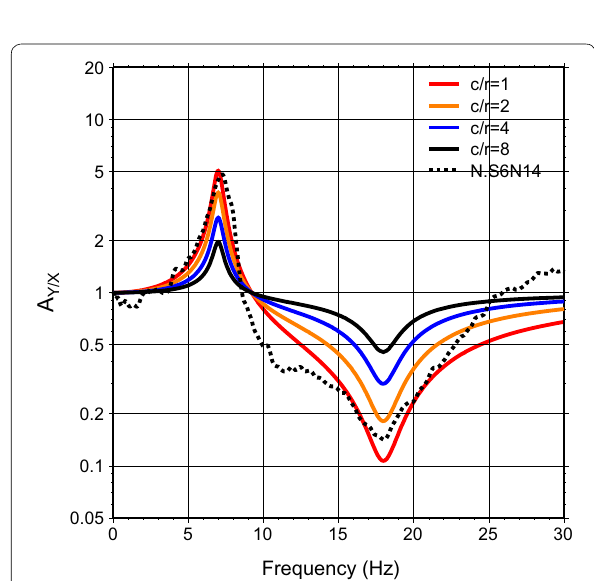
Fig. 12 Theoretical Y/X amplitude spectral ratios calculated using a natural vibration model. Natural frequencies of the X and Y components were set to 18 and 7 Hz, respectively, and the damping constant was set to 0.05 for both components. Different colors represent results for different c / r values. The dotted black curve represents the Y/X amplitude spectral ratio observed at station